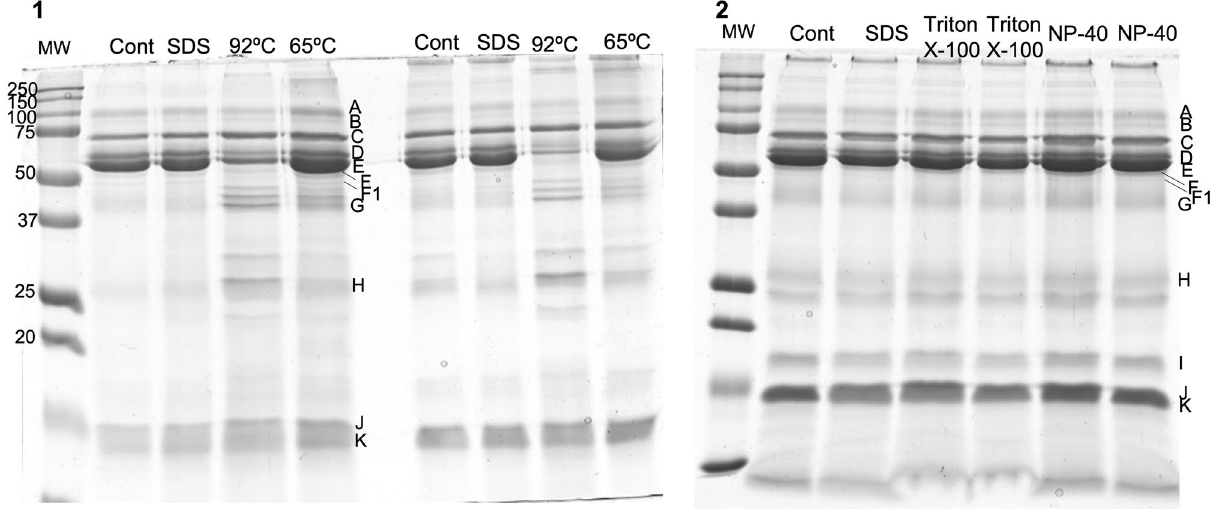
Figure 1. Example of SDS-PAGE profiles of the same individual’s saliva sample subjected to the different treatments: ( 1 ) Control, SDS, heat treatment at 92 °C; heat treatment at 65 °C; ( 2 ) control, SDS, Triton X-100; NP-40; (letters represent the protein bands considered for analysis, which were previously identified as containing: A—IgG polymeric receptor; B-—transferrin; C—albumin; D, E and F—salivary amylase; F1—not identified; G—Zinc-α2-glycoprotein + Carbonic anhydrase VI; H—immunoglobulin light chains; I—prolactin induced protein; J and K—cystatins; MW—molecular mass